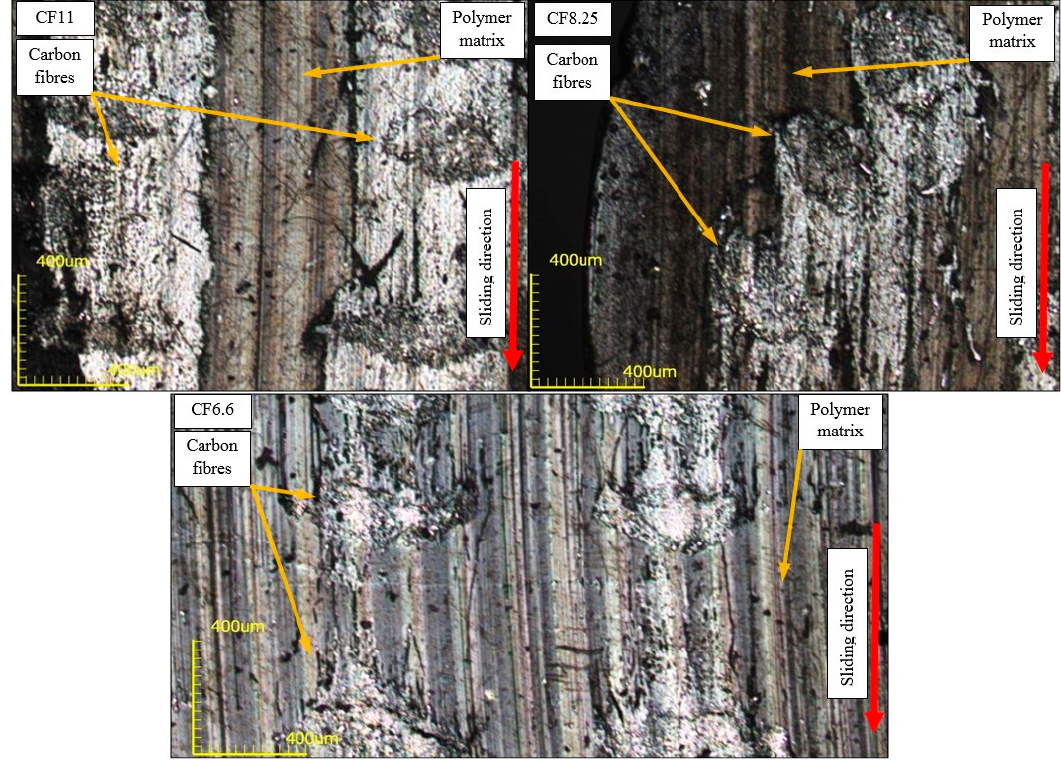
Figure 14. Surfaces of acrylonitrile-butadiene-styrene (ABS) CF11; CF8.25; CF6.6 composites after wear testing in a water environment.